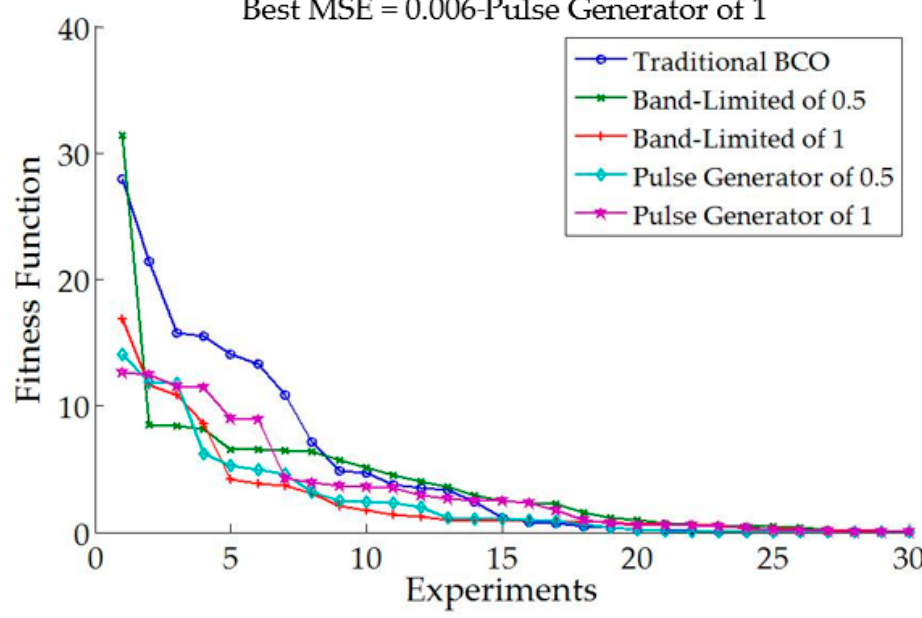
Figure 15. Behavior of the traditional BCO with different perturbation in the model.